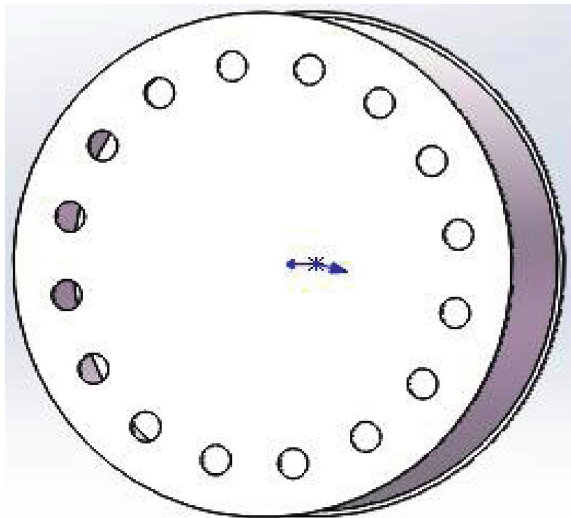
Figure 4: Structure of the front smoke chamber.